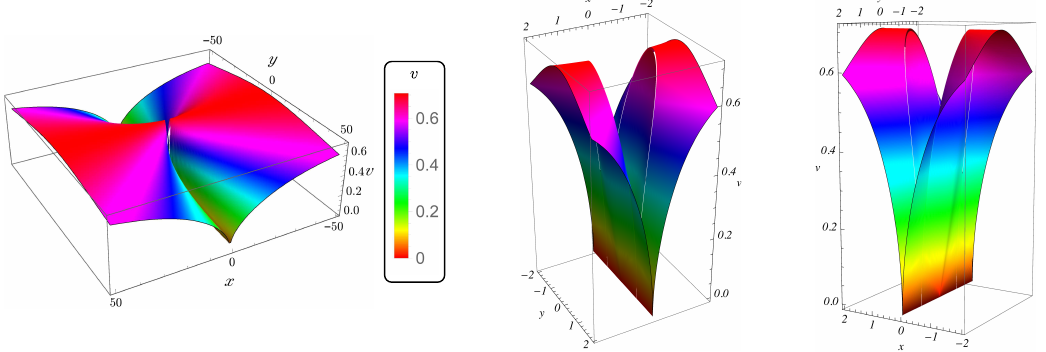
Figure 3. Same as Figure 1 but with anisotropic Newton’s law and with α = 0 and β =